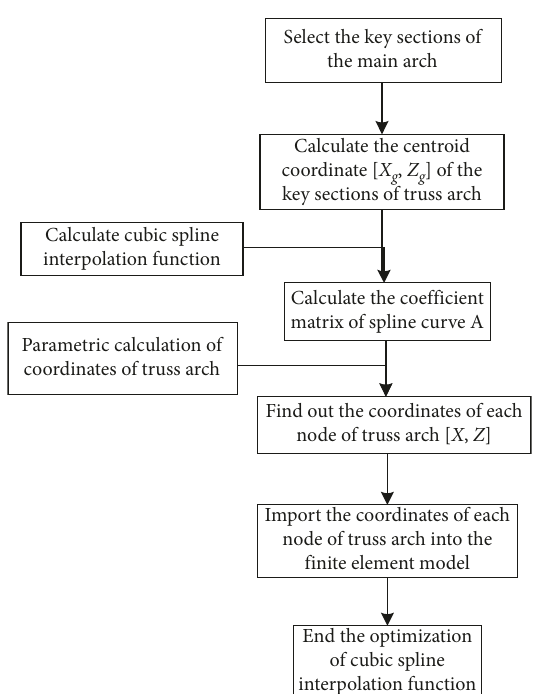
Figure 5: Optimization of the cubic spline interpolation